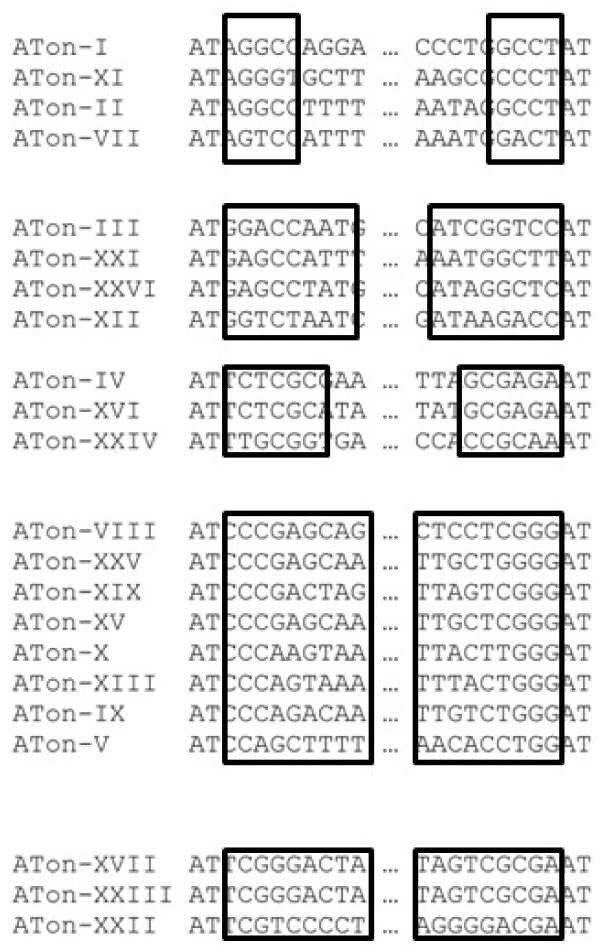
 Grouping of ATon families inA.aegypti. Boxed regions, similar terminal sequences; Dots, omitted internal sequences.